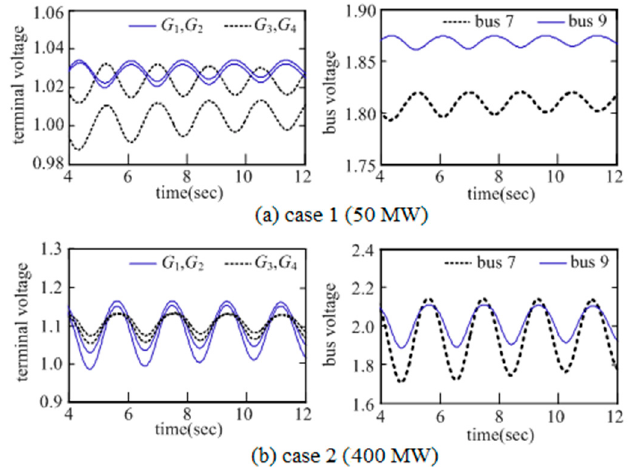
Figure 8. Sync of generator and bus voltage in two-area system: ( a ) Case 1 (power flows: 50 MW); and ( b ) Case 2 (power flows: 400 MW).